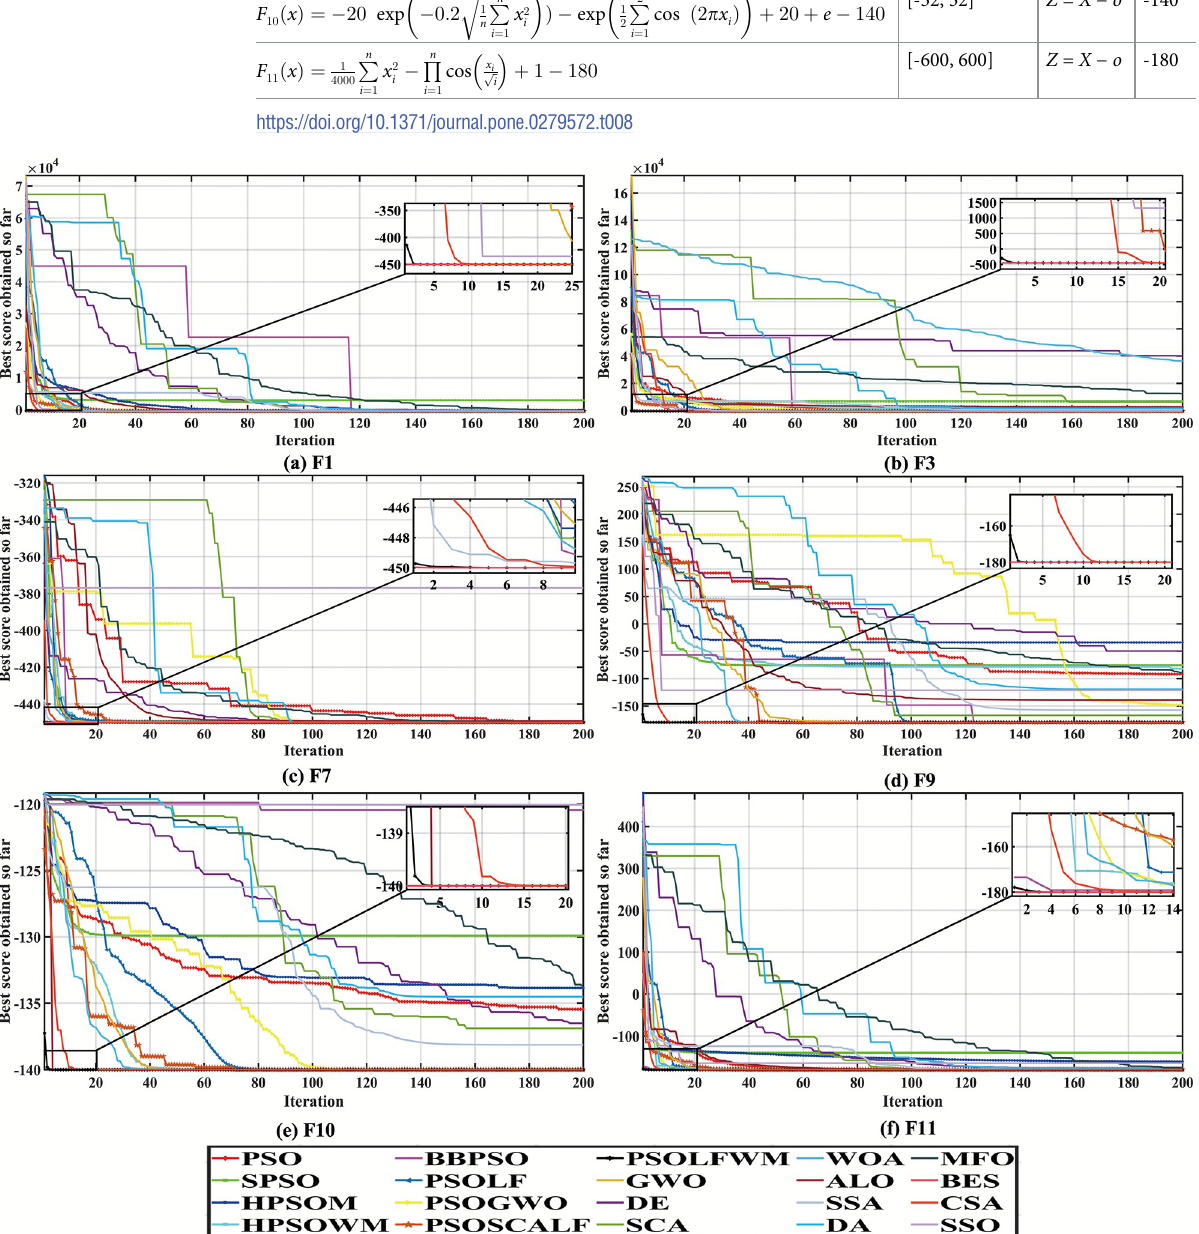
Fig 8. Convergence curve of shift function. (a) F1, (b) F3, (c) F7, (d) F9, (e) F10, and (f) F11.